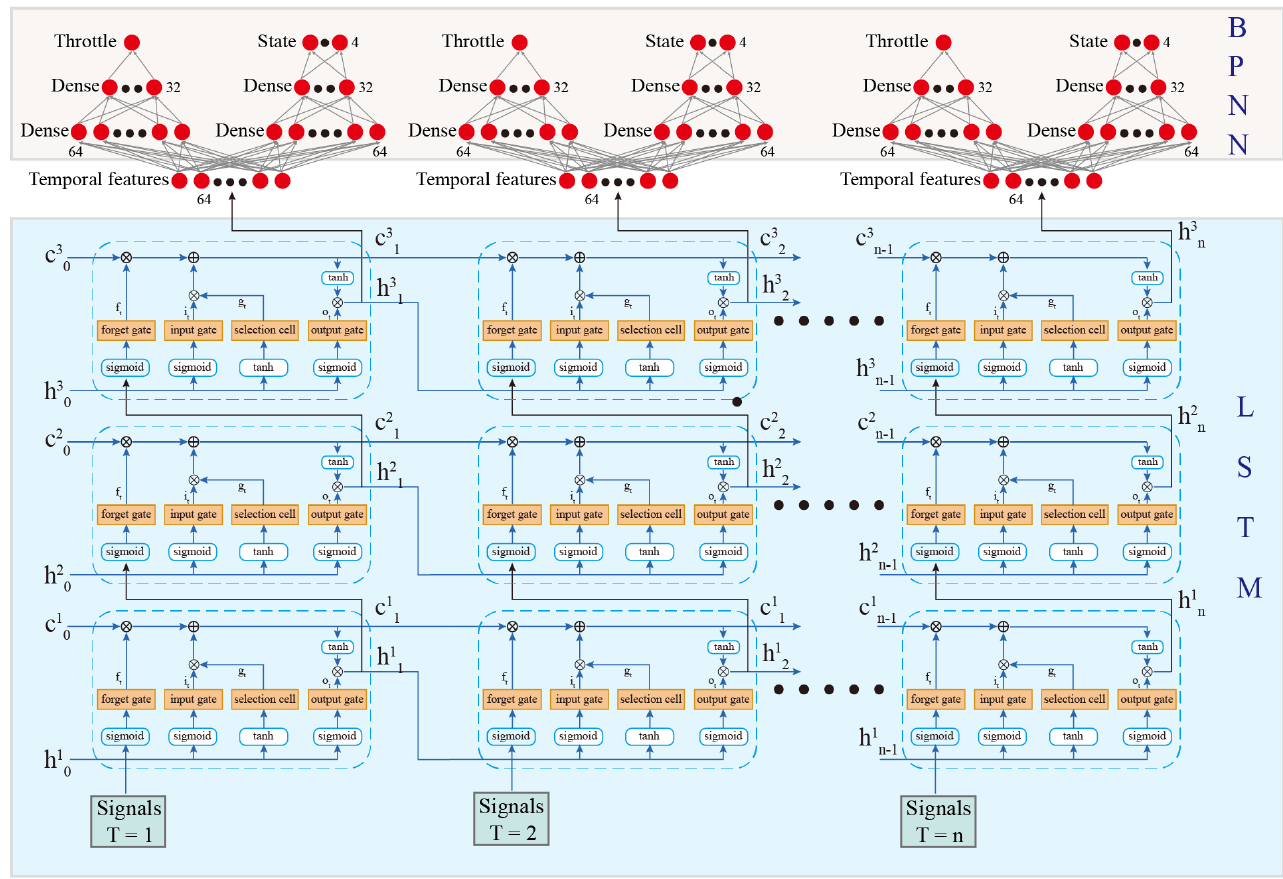
Figure 7. Structure of the proposed LSTM and